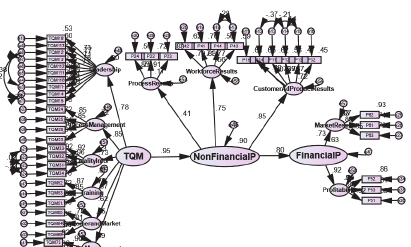
Fig. 3. Results for the mediating effect of non – financial